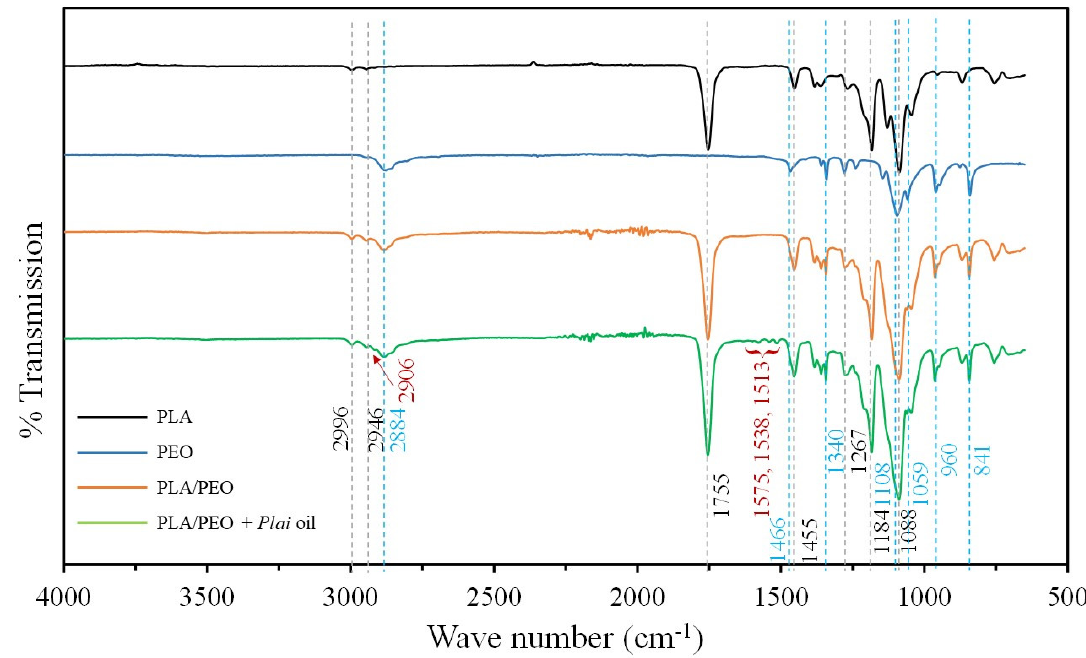
Figure 4. FTIR spectrum of pristine PLA, pristine PEO, the PLA/PEO fiber blend, and the oil-loaded PLA/PEO fiber blend membranes.